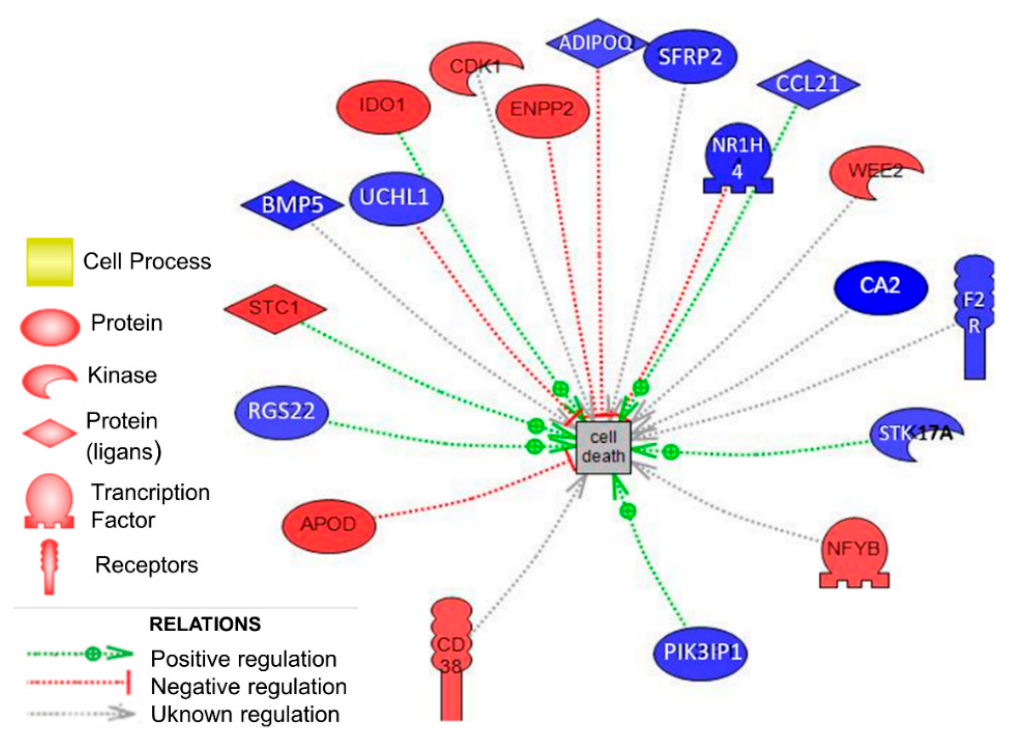
Figure 3. Customized subnetwork analysis focused on nineteen genes involved in cell death in ovarian tissue. Up-regulated (in red) and down-regulated (in blue) genes in the line selected for ovulation rate during 10 generations (OR line) vs. the control line (C line). The dashed line means the regulation relationship. Relations are colored by effect: Red color expressed a negative effect, green color expressed a positive effect, and grey expressed unknown effects. Table 3. Nineteen significant differentially expressed genes involved in cell death in ovarian tissue. Gene Symbol